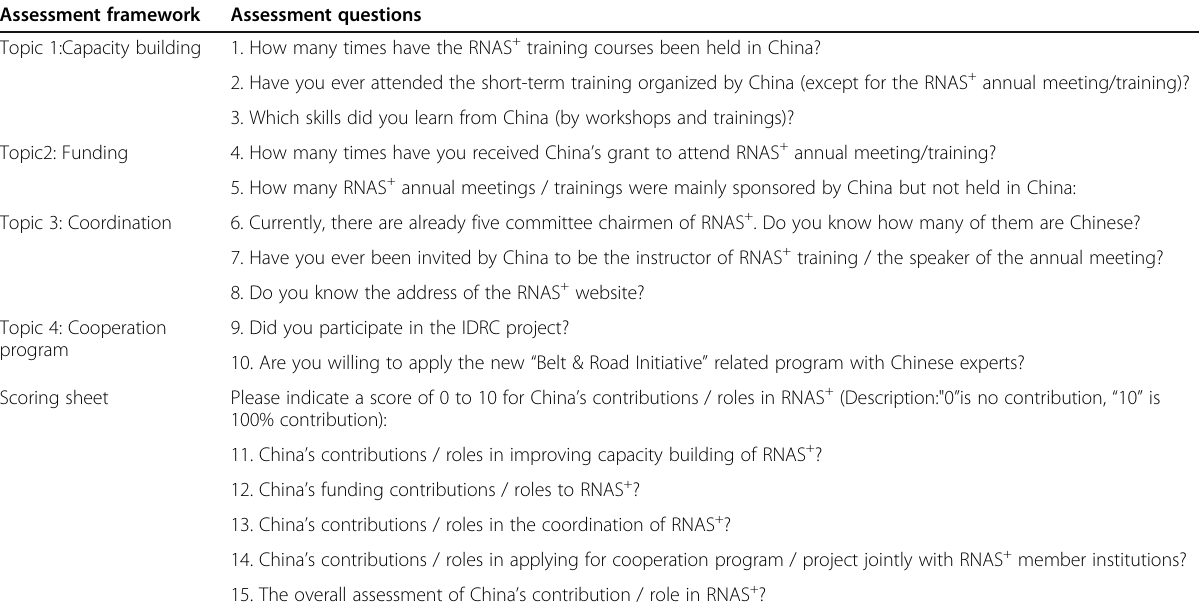
Table 1 Assessment framework of interview